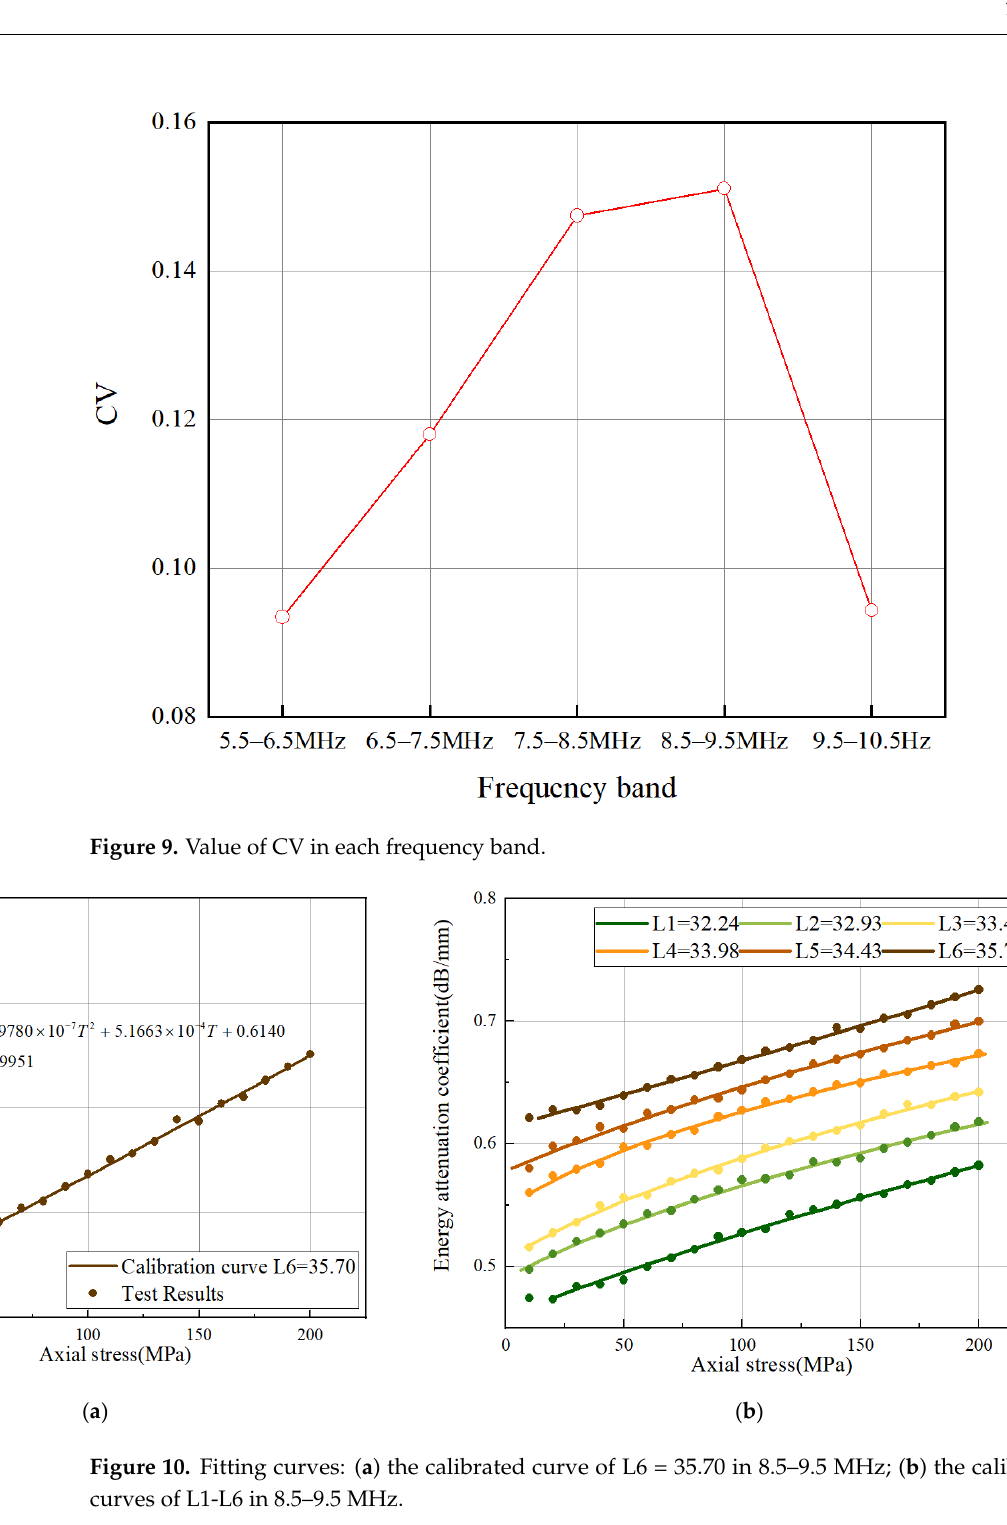
Figure 10. Fitting curves: ( a ) the calibrated curve of L6 = 35.70 in 8.5–9.5 MHz; ( b ) the calibrated curves of L1-L6 in 8.5–9.5 MHz.